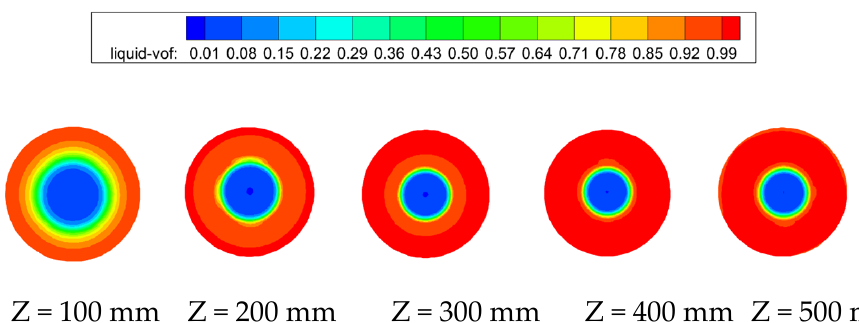
Figure 9. Liquid phase distribution in different positions of separator inner cylinder .